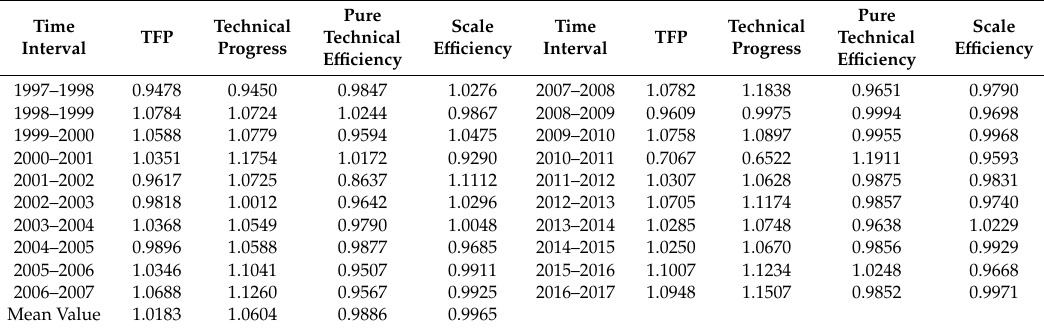
Table 3. Annual TFP index and its decomposition in